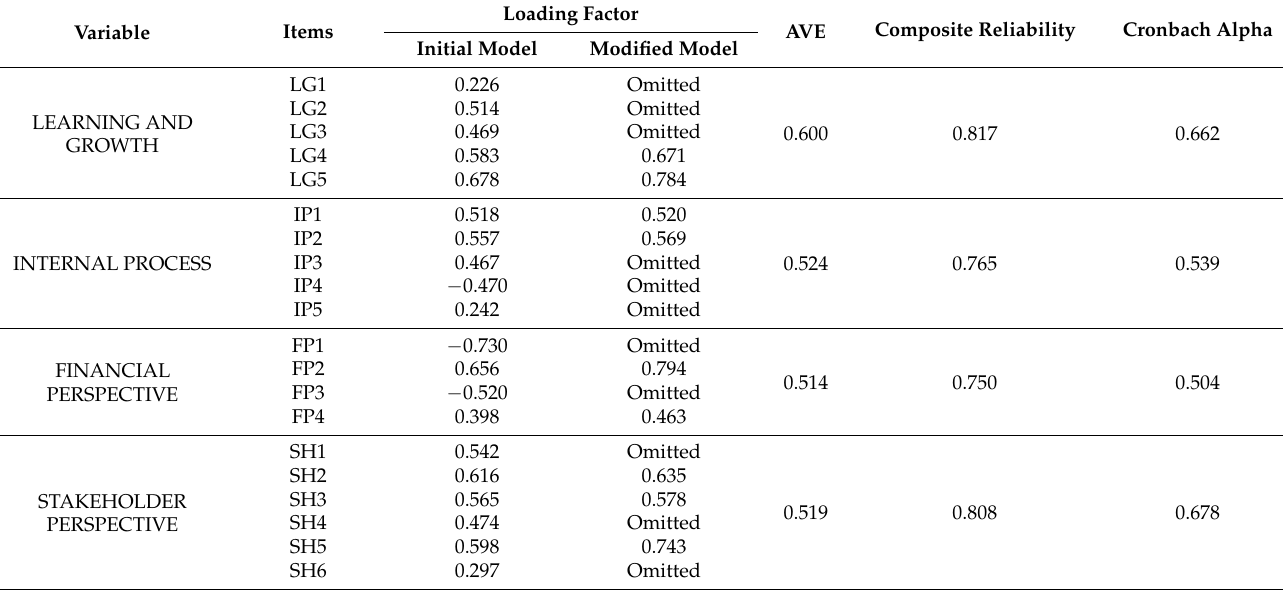
Table 4. Construct Validity of the Measurement Model for Organisational Performance (OP).